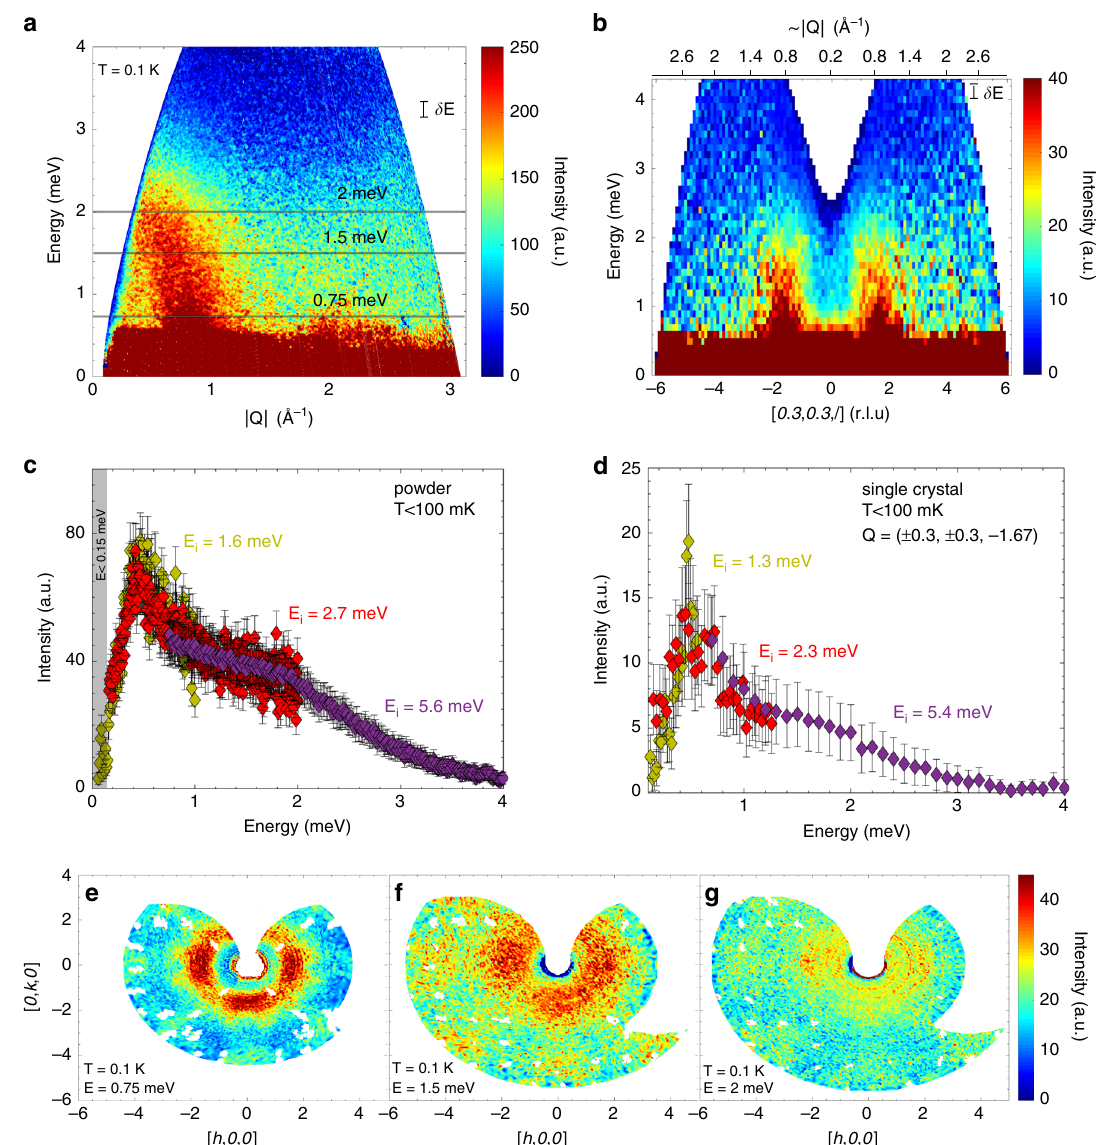
Fig. 3 Magnetic inelastic neutron scattering data of PbCuTe 2 O 6 measured at temperatures of T < 0.1 K. a , b Excitation spectra obtained on powder and single crystal using the time-of- fl ight spectrometer LET, with an incident energy of E i = 5.6 meV and E i = 5.4 meV respectively. These plots clearly show the presence of a diffuse, dispersionless continuum of magnetic excitations originating at | Q | ≈ 0.8 Å − 1 extending up to E ≈ 3 meV. c Powder magnetic intensity plotted as a function of energy for data collected on LET with E i = 5.6 meV (resolution δ E = 0.18 meV, integration range 0.5 ⩽ | Q | ⩽ 1.2 Å − 1 ), E i = 2.7 meV ( δ E = 0.08 meV, 0.55 ⩽ | Q | ⩽ 1.1 Å − 1 ) and E i = 1.6 meV ( δ E = 0.03 meV, 0.56 ⩽ | Q | ⩽ 1.0 Å − 1 ). The background of each dataset has been subtracted and the datasets have been normalised to each other. The shaded area ( E < 0.15 meV) indicates the region below which data is unreliable due to subtraction of the incoherent background. The error bars here represent statistical errors. d Similiar plot for single crystal data measured on LET with incident energies E i = 5.4 meV (resolution δ E = 0.18 meV, integration range 0 ⩽ [ h , h , 0] ⩽ 0.6 r.l.u, − 2.75 ⩽ [0, 0, l ] ⩽ − 0.25 r.l.u), E i = 2.3 meV ( δ E = 0.06 meV, − 1 ⩽ [ h , h , 0] ⩽ 1 r.l.u, − 1.95 ⩽ [0, 0, l ] ⩽ − 0.95 r.l.u) and E i = 1.3 meV ( δ E = 0.03 meV, 0.95 ⩽ [ h , h , 0] ⩽ 2.4 r.l.u, − 2.97 ⩽ [0, 0, l ] ⩽ 2.97 r.l.u). e – g Single crystal spectra measured on the MACS spectrometer in the [ h , k , 0] – plane at constant energy transfers of E = 0.75 meV, 1.5 meV and 2 meV respectively. Non-magnetic features such as phonons and Bragg peak tails have been removed from the spectrum. The colour map at 0.75 meV reveals a broad, diffuse ring-like feature at | Q | ≈ 0.8 Å − 1 whose intensity modulates with maxima at (1.69, ±0.3, 0), and equivalent positions. Similar features are present at higher energies with reduced intensity. The uncertainties in fi gures c , d represent